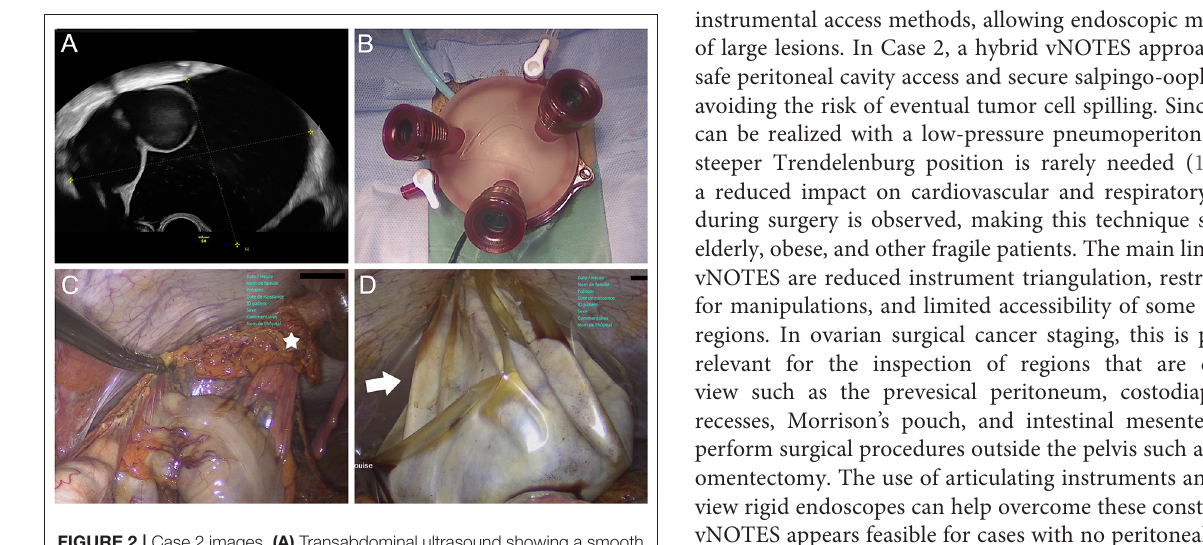
FIGURE 2 | Case 2 images. (A) Transabdominal ultrasound showing a smooth multilocular cyst (max diameter 17cm) originating from right adnexa. (B) Installation of the GelPOINT V-Path Transvaginal Access Platform for vNOTES. (C) Hybrid vNOTES infracolic omentectomy with removal of greater omentum (white star) from 12-mm supraumbilical trocar. (D) Hybrid vNOTES approach with transvaginal view of transabdominal extraction of right adnexal mass into endobag (white